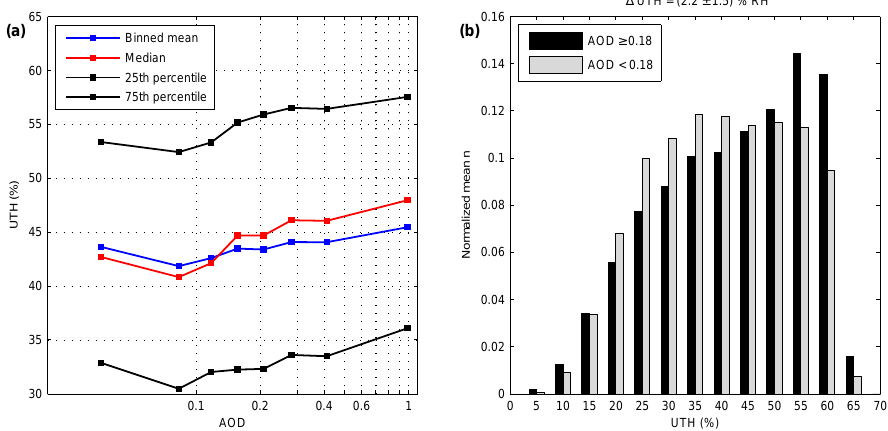
Figure 6. (a) UTH as a function of AOD and b, histogram of UTH in case of low and high AOD east of China (120–149 ◦ E, 25–45 ◦ N) in June, July and August in 2007–2013. In both figures only data from 1 ◦ × 1 ◦ grid cells with precipitation values of more than 1mmday − 1 are shown. Binned mean values are averages over 10 precipitation bins. Cirrus dependence has been removed from the AOD data (see Fig. 4).